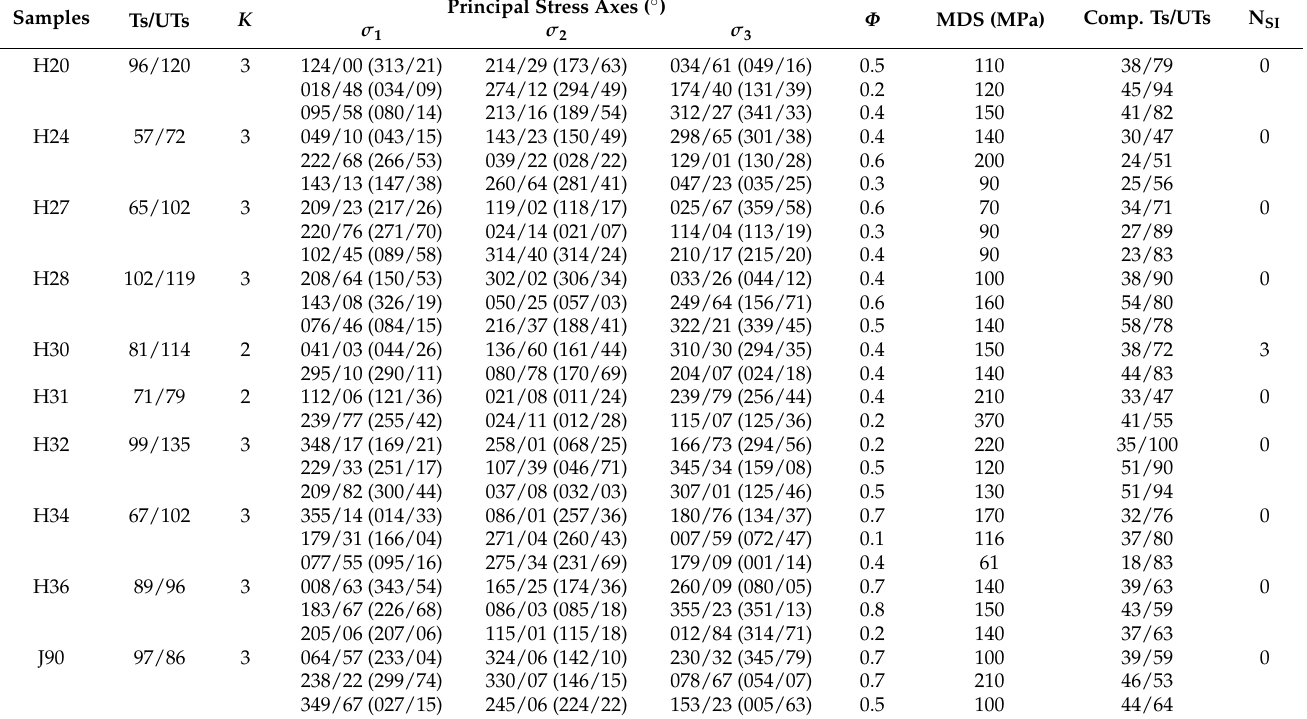
Table 3. Stress results by applying the improved version of Shan et al.’s (2019) method to calcite thin-twin datasets measured for samples from the Longshan Dome. σ 1 , σ 2 , and σ 3 represent the orientations (bearings and plunges) or magnitudes of the maximum, intermediate, and minimum principal stresses. Their orientations in the untilted state are bracketed. K is the phase number. Ts and UTs are twinned e-planes and untwinned e-planes. The stress ratio, Φ , is defined as ( σ 2 – σ 3 )/( σ 1 – σ 2 ). MDS is the maximum differential stress, σ 1 – σ 3 . N SI is the number of incompatible (twinned and untwinned) e-planes to all